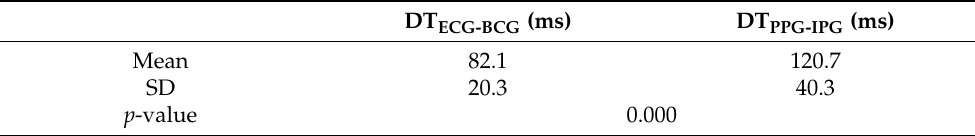
Table 7. The statistic of delay time (DT ECG-BCG ) between the ECG and BCG, and delay time (DT PPG-IPG ) between the PPG and